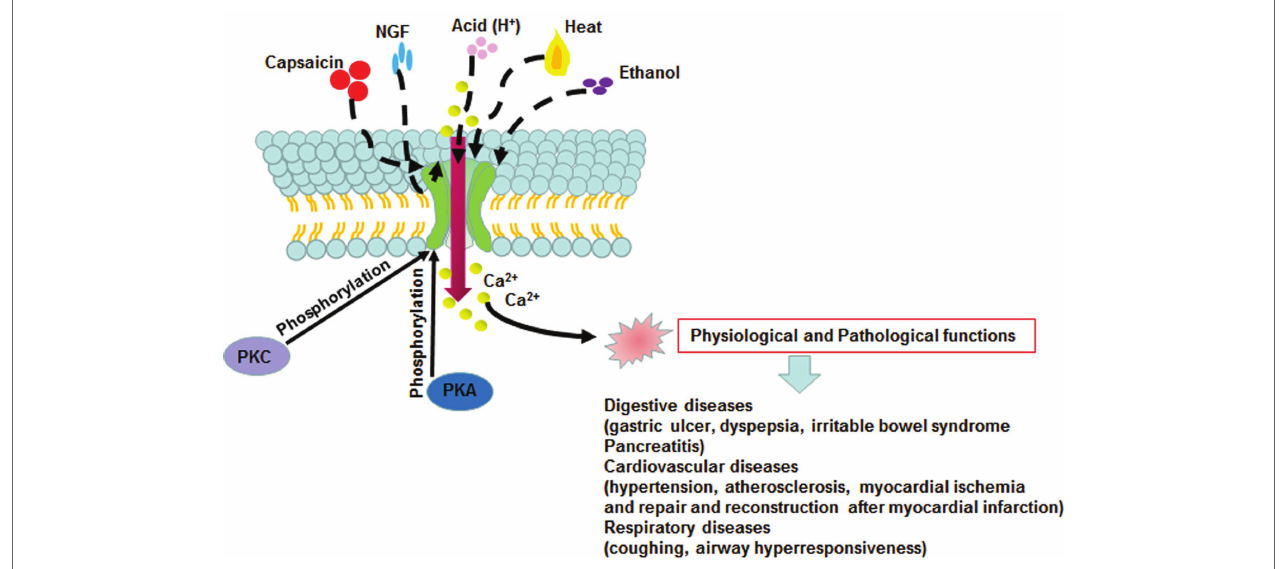
FIGURE 3 | TRPV1 channel activation and its function in mammalian cell. The TRPV1 can be activated by capsaicin, heat, acidosis, NGF, ethanol phosphorylation PKA and PKC. The activation of TRPV1 induces an influx of extracellular Ca 2+ , resulting in increased intracellular calcium, and regulates the corresponding physiological and pathological